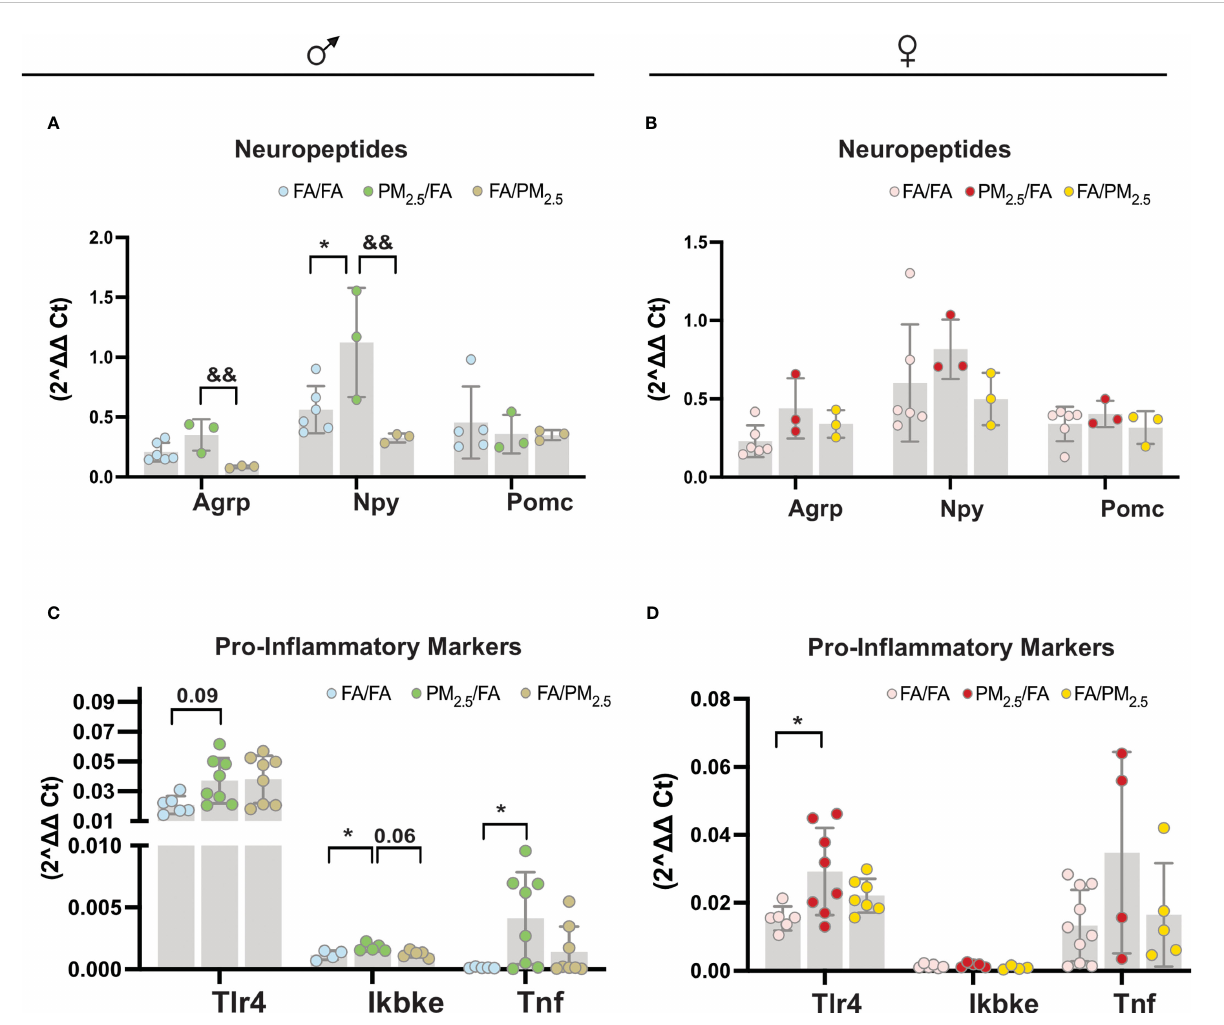
FIGURE 2 Maternal exposure to PM 2.5 alters hypothalamic neuropeptide expression and pro-in fl ammatory signals signi fi cantly in the offspring. (A) (males): Agrp (Agouti- related protein); Npy (neuropeptide Y); and Pomc (Pro-opiomelanocortin) expression in the hypothalamus n=3-6. (B) (females): Agrp (Agouti-related protein); Npy (neuropeptide Y). And Pomc (Pro-opiomelanocortin) expression in the hypothalamus n=3-6. (C) (males): Tlr4 (Toll-like receptor 4); Ikbke and Tnf alpha (Tumor necrosis factor-alpha) expression in the hypothalamus n=4-8. (D) (females): Tlr4 (Toll-like receptor 4); ikke and Tnf alpha (Tumor necrosis